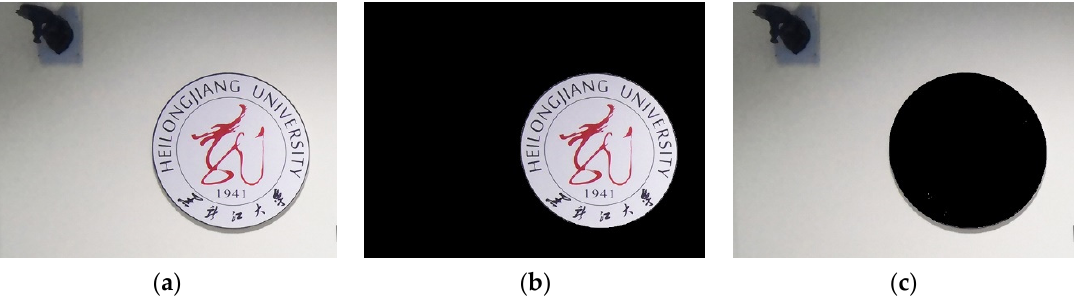
Figure 3. Foreground and background image segmentation. The part of the badge of Heilongjiang University is the foreground and the rest is the background: ( a ) origin image; ( b ) foreground; ( c ) background.